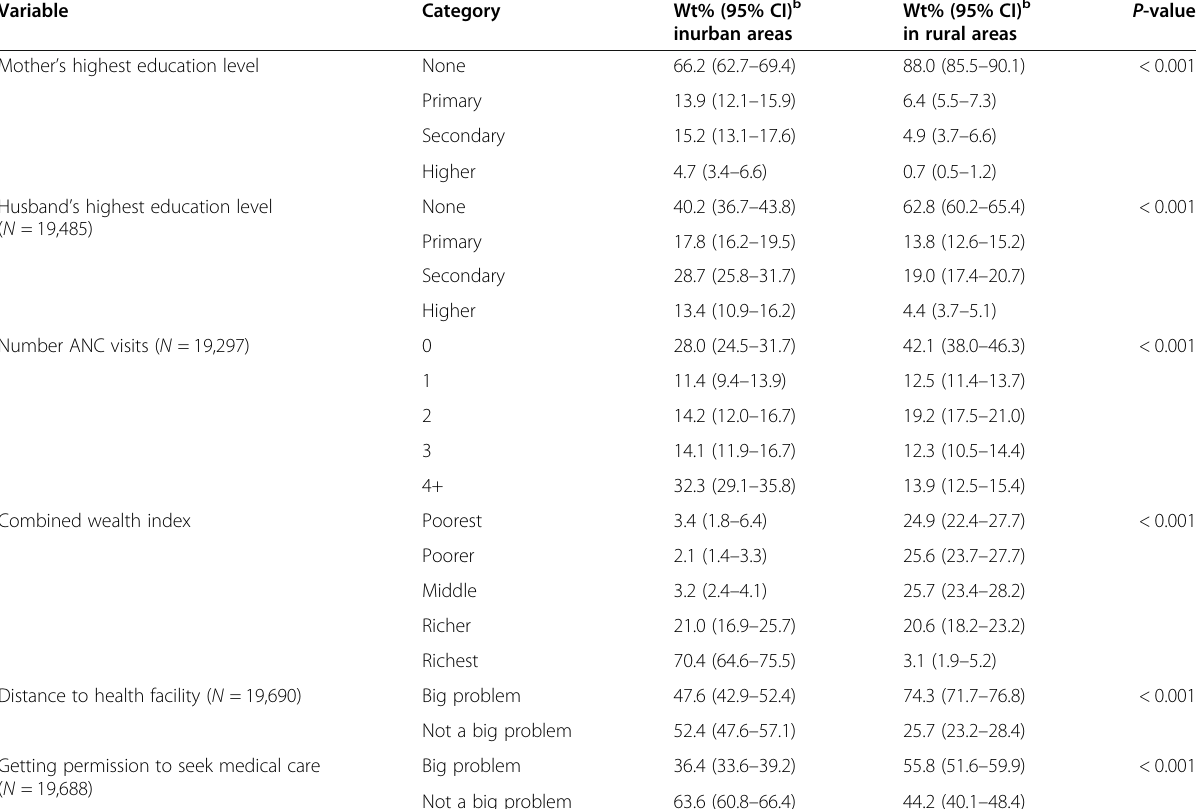
Table 4 Associations between confounders of the main association and area of residence a